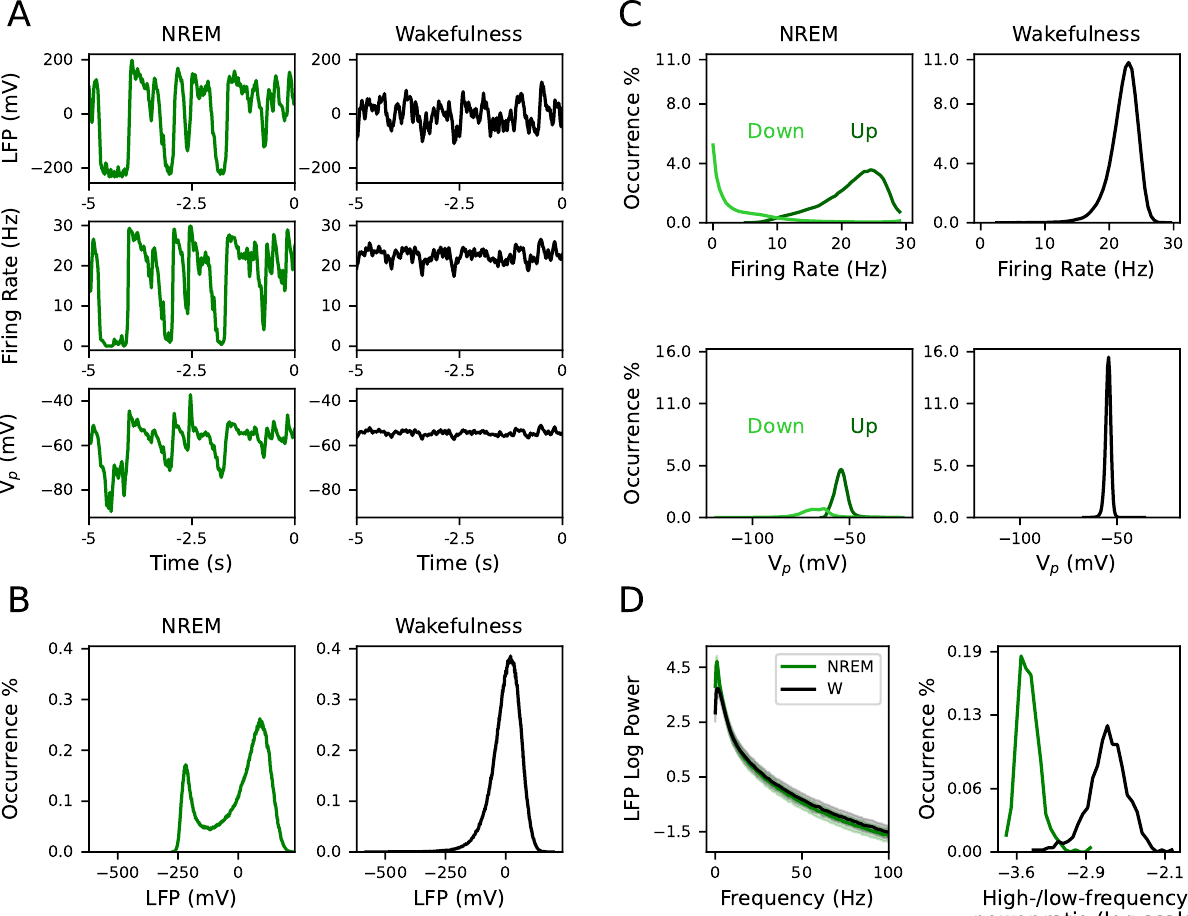
Figure 2. Spontaneous activity ( ξ = 0) during NREM sleep and wakefulness in the one-cortical-column model. ( A ) Simulated signals from one random simulation showing large amplitude fluctuations during NREM sleep between Up and Down states (left column). Lower amplitude fluctuations appear during wakefulness (right column). The first, second and third row correspond to LFP, firing rate and V p signal, respectively. ( B ) The distribution of the LFP signals is bimodal during NREM sleep and unimodal during wakefulness. The half distance between the two peaks of the NREM distribution is used to extract Up and Down events from the LFP. ( C ) Top row: The distribution of the firing rate during Up states (dark green) shows the persistent activity mode, while the Down state distribution (light green) is a silent activity mode. The distribution of firing rate during wakefulness shows a unimodal distribution. The distribution during wakefulness and Up states have similar means. Bottom row: The distribution of the V p signal during Up (dark green) and Down (light green) events differ. It has a more depolarized mean value during Up states (close to the mean value during wakefulness) than Down states. The bigger area of the distributions of Up events indicates that they are more prevalent than Down events in the modeled NREM sleep. ( D ) Spectral content of LFP signals during NREM sleep and wakefulness. Left: Average power spectrum density of LFP signals during NREM sleep (green) and wakefulness (black). The shaded area corresponds to the standard deviation of the mean of PSD over 500 simulations during NREM sleep and wakefulness. Right: Distribution of high-/low-frequency (where high is above 30 Hz and low is below 4 Hz) power ratio in the LFP during NREM sleep (green) and wakefulness